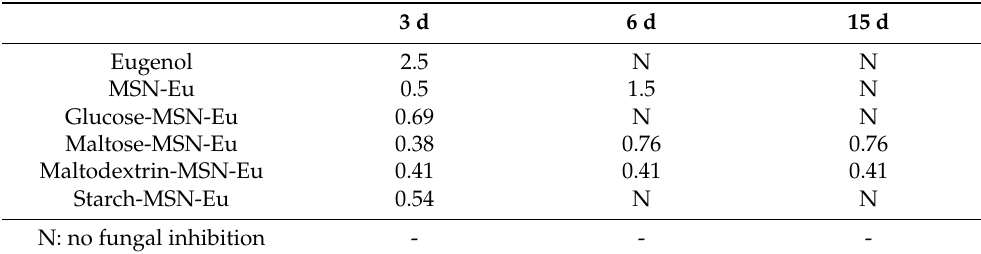
Table 4. Minimal inhibitory doses (MIDs, mg/Petri dish) of eugenol and mesoporous silica systems with different saccharide gates.